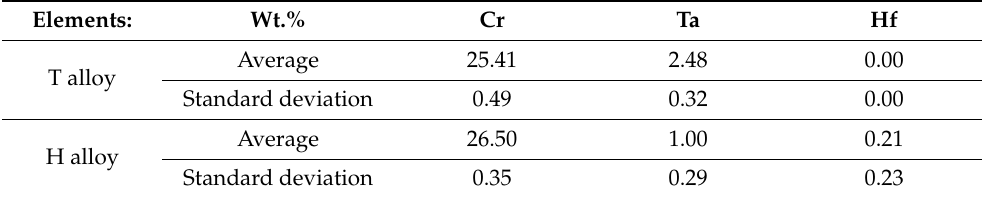
Table 6. Chemical composition of the matrixes of the two alloys after exposure at 1250 ◦ C for 50 h. Elements: